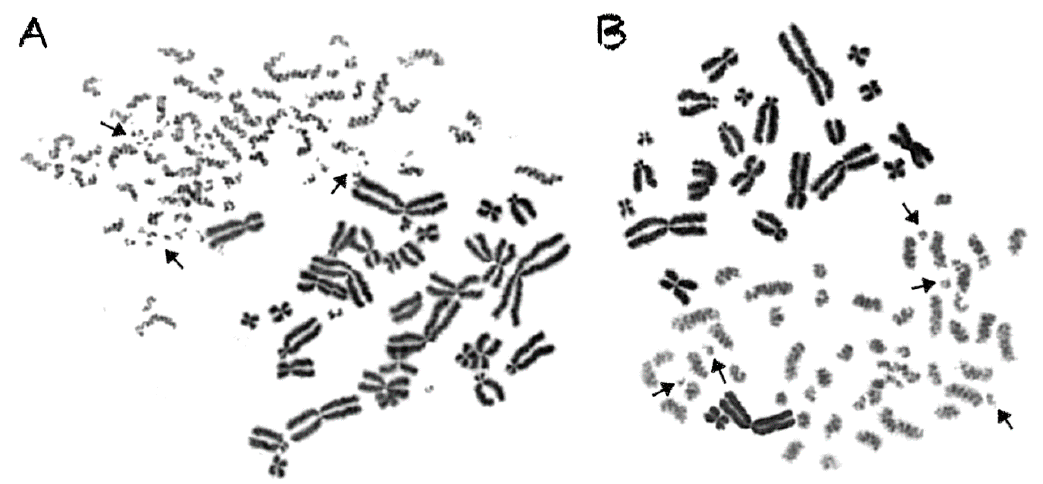
Figure 7. Shattered chromosome domains are very frequent in G0 lymphocyte PCCs following exposure to high-LET particle radiations, compared with γ -rays. ( A ) Exposure to even 1 Gy of α -particles can result in three localized shattered chromosome domains, as shown by arrows. ( B ) In contrast, following 1 Gy of γ -rays, only single randomly distributed chromosome fragments could be visualized. Therefore, such localized shattering of targeted chromosome domains may be considered as a fingerprint of exposure to high-LET particle radiation.